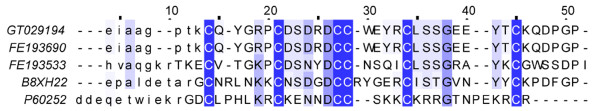
Sequence alignment of Calcine. GT02s represent the dbEST accession numbers for Yunnan-sourced Lychas mucronatus cDNA library. FE19s represent the dbEST accession numbers for Hainan-sourced Lychas mucronatus cDNA library. B8XH22 represents Tx758 from Buthus occitanus Israelis. P60252 represents Opicalcine-1 from Opistophthalmus carinatus. Lower case amino acids represent putative pro-sequences.